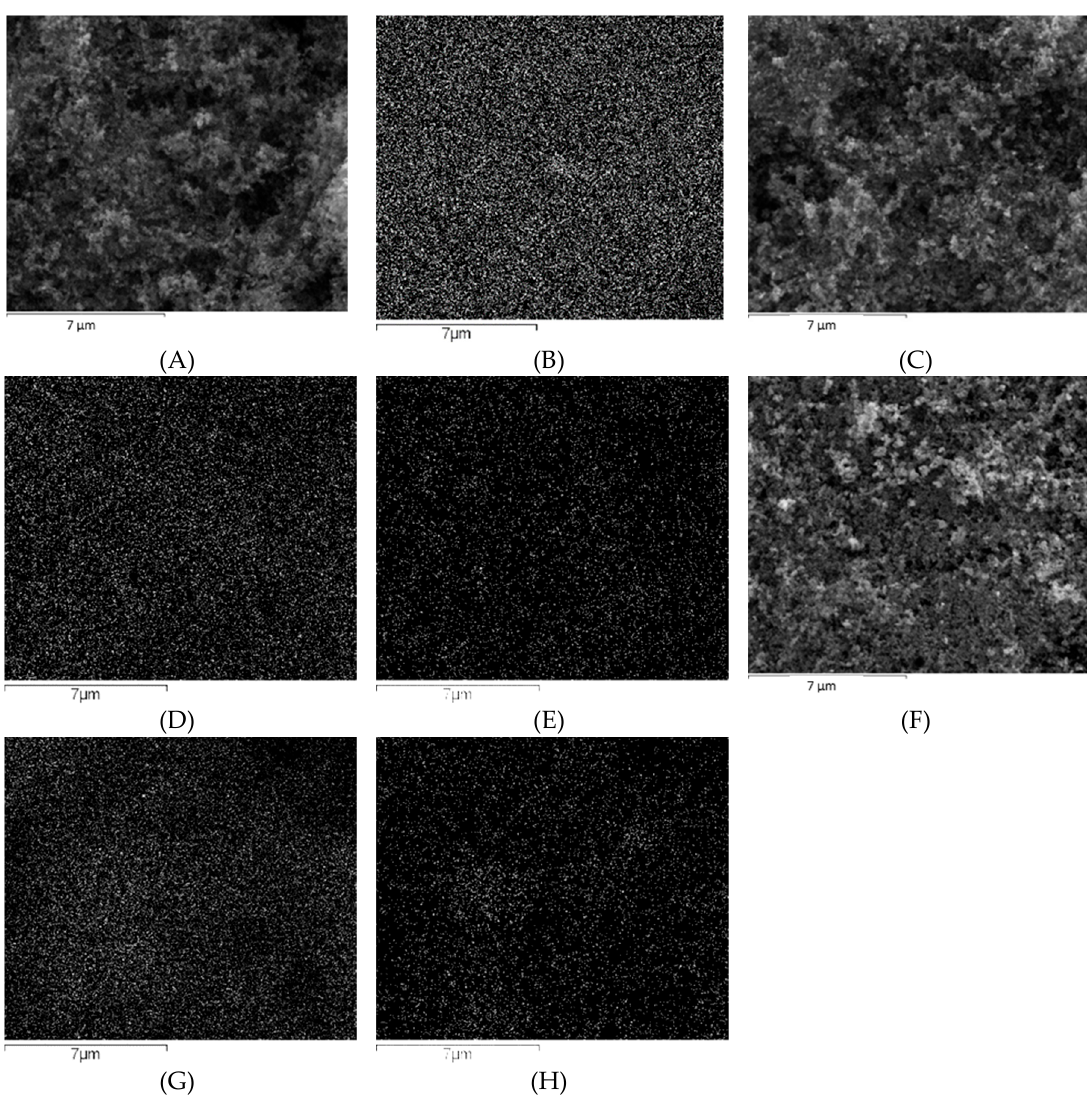
Figure 1. SEM-EDS elemental mapping images of Pt 20 /C (A,B), Pt 20 /SnO x8 /C ( C – E ) and Pt 20 /SnO x12 /C Figure ( F – H ). Pt mapping is shown in B, D , and G ; Sn mapping is shown in E and H .